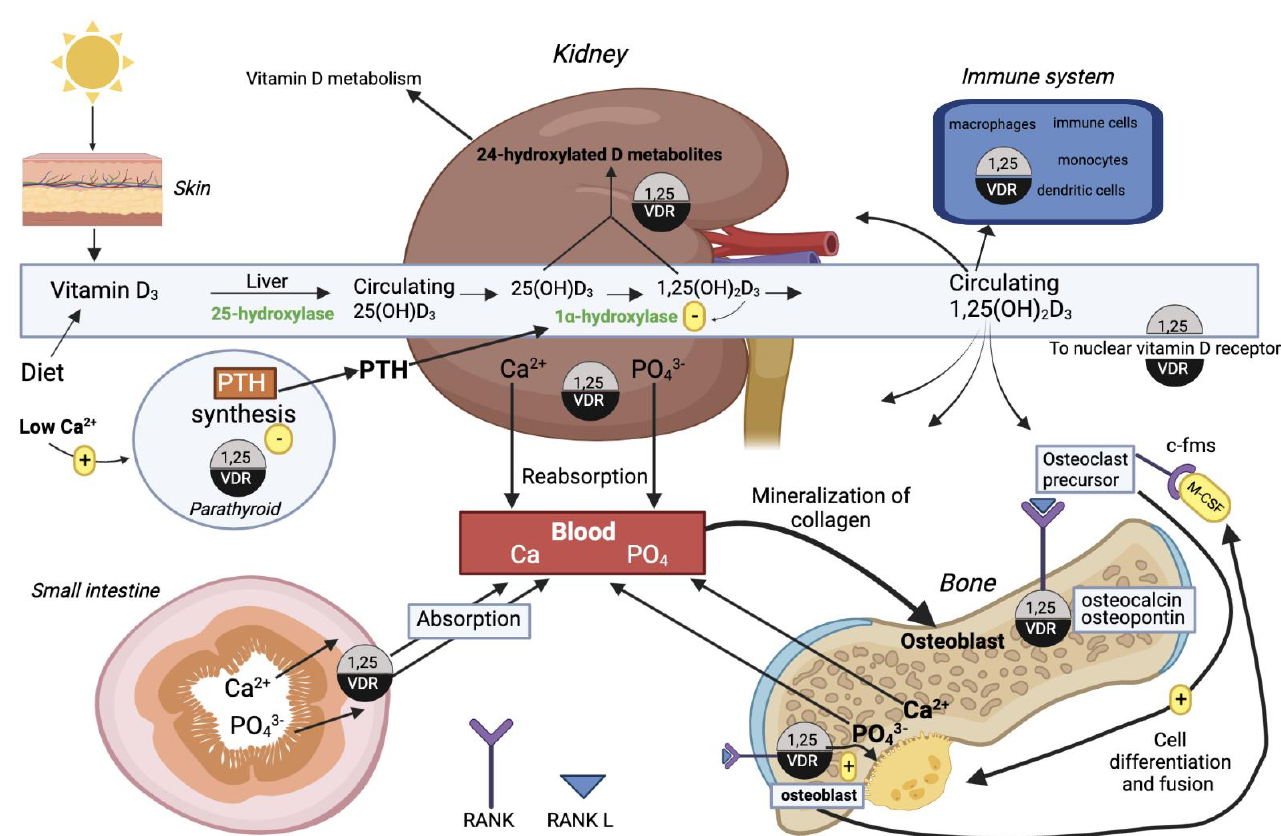
Figure 4. Effects of vitamin D and its metabolites in calcium homeostasis, bone metabolism, and the immune system. Vitamin D 3 obtained from the diet or synthesized by photoconversion from sunlight is converted into the hormonal form 1,25(OH) 2 D 3 by two hydroxylations occurring in the liver and kidney, respectively. After this conversion, 1,25(OH) 2 D 3 circulates in blood to target tissues. The integrated actions of the 1,25(OH) 2 D 3 hormone via binding to the intracellular VDR, to control calcium homeostasis in bone, kidney, intestine, and parathyroid, is shown above [64]. This figure was made using Biorender.com, agreement number